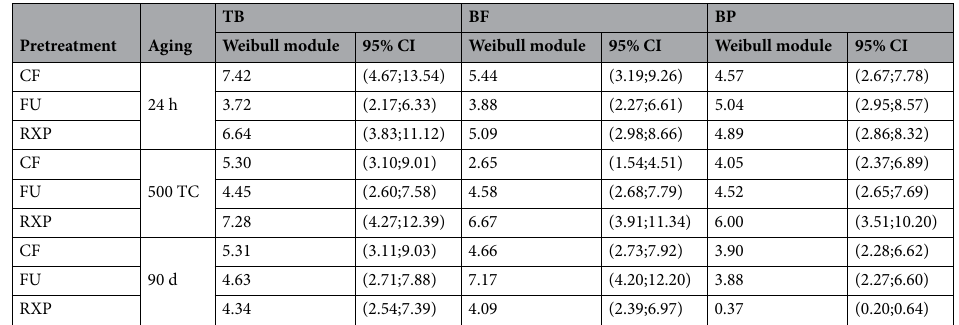
Table 3. Weibull moduli. Calculated according to the maximum likelihood estimation method with 95% confidence interval for each group separately. TB Transbond XT, BF BrackFix, BP bracepaste, CF Clearfil ceramic primer plus, FU Futurabond U, RXP RelyX ceramic primer.